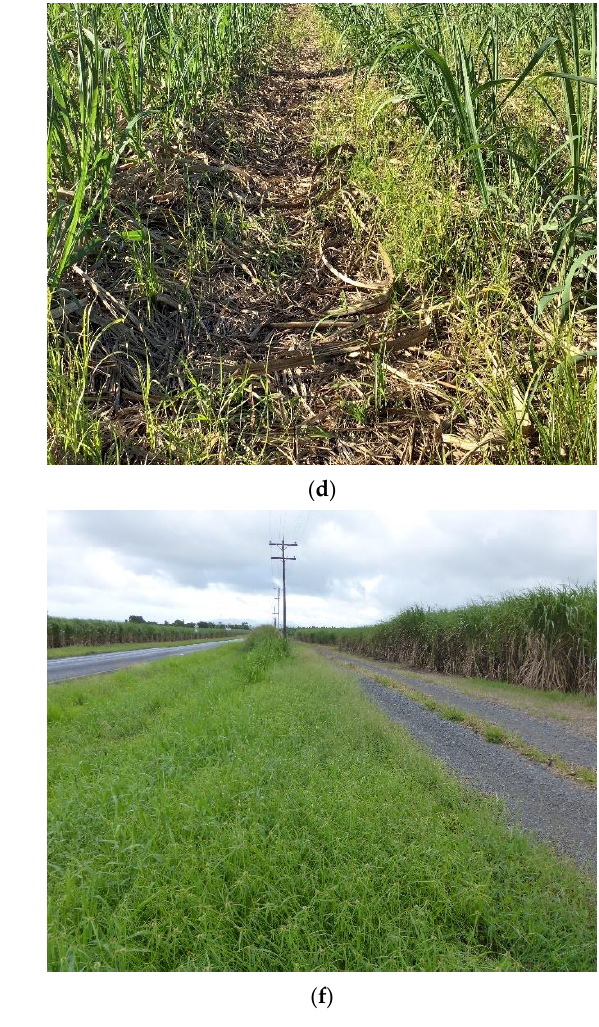
Figure 2. The invasion of Navua sedge ( Cyperus aromaticus ) in Australia; ( a ) near railway, ( b ) pasture land; ( c , d ) sugarcane Figure 2. Cont farms, ( e ) along the creek, ( f ) along the roadside.